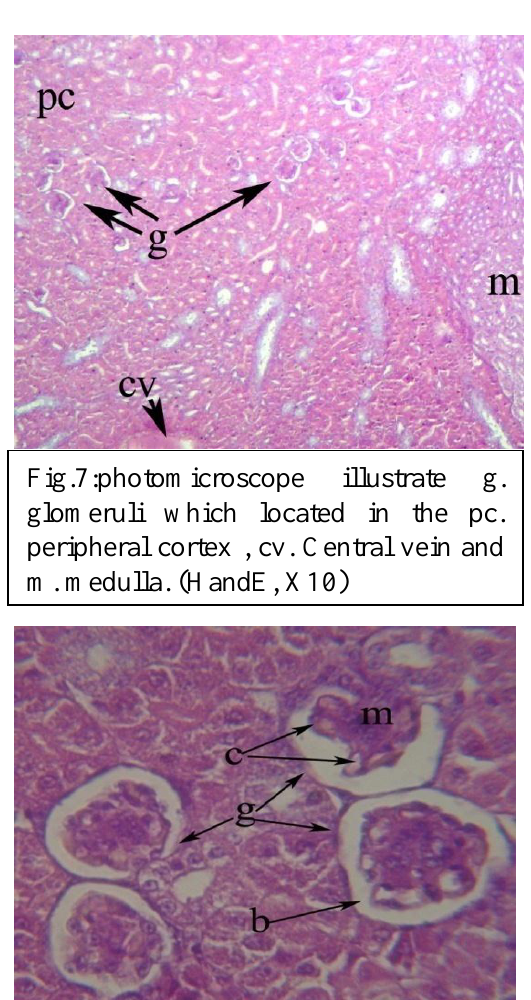
Fig. 9: photomicroscope illustrate m. mesangial cell g. glomeruli c. capillary lope b. Bowman's capsule and space. (HandE, X40).